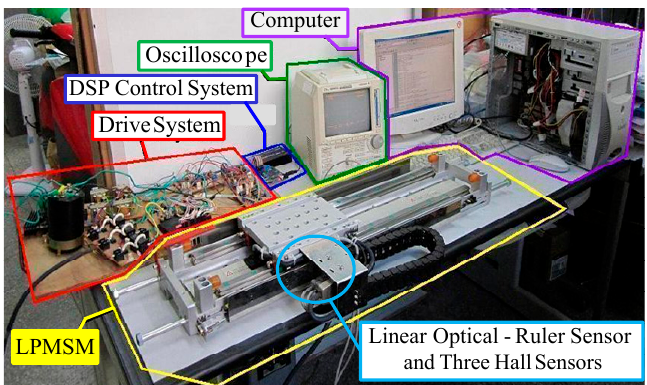
Figure 7. An experimental set-up picture of the LPMSM drive system.